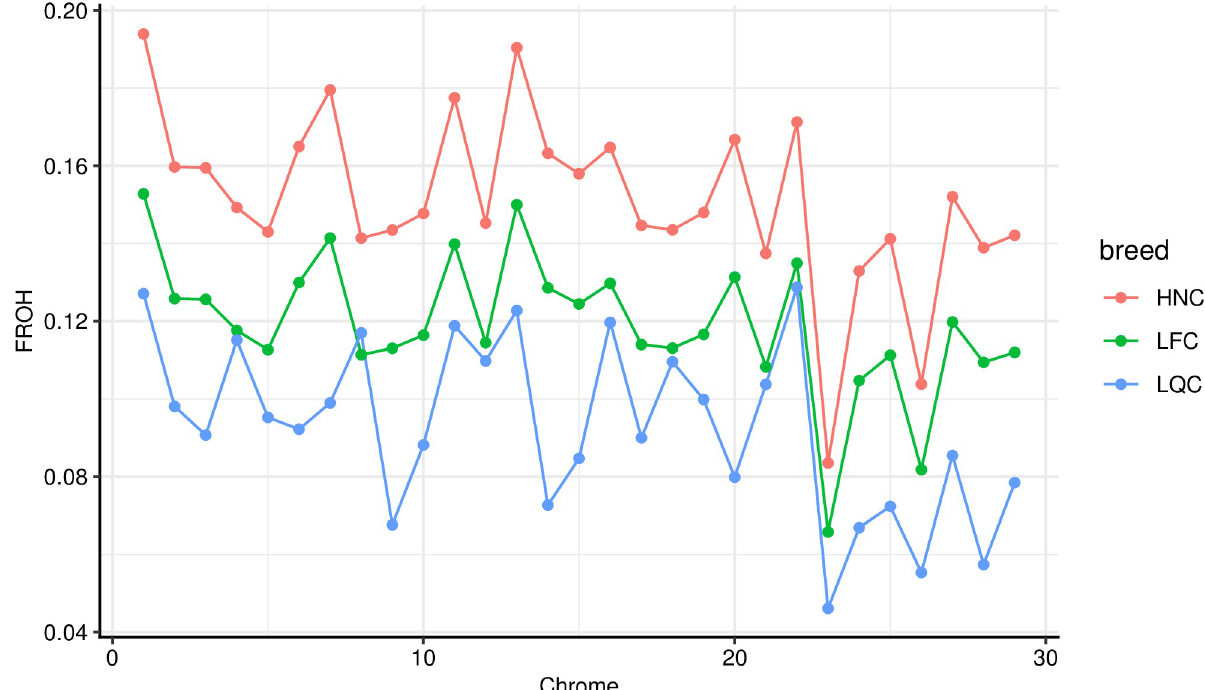
Fig 4. Line plot of inbreeding coefficient for each chromosome among the three